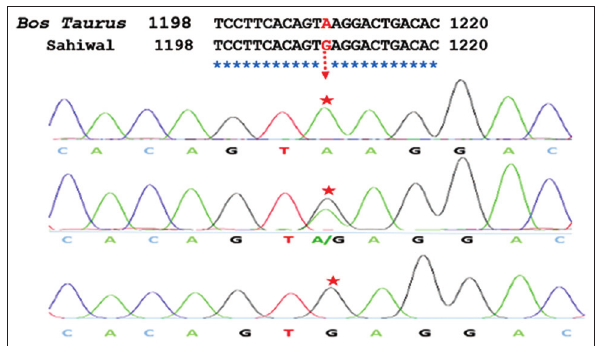
Figure 2: Chromatograph showing SNP at position 1209 A>G of HSP90AA1 gene in Sahiwal